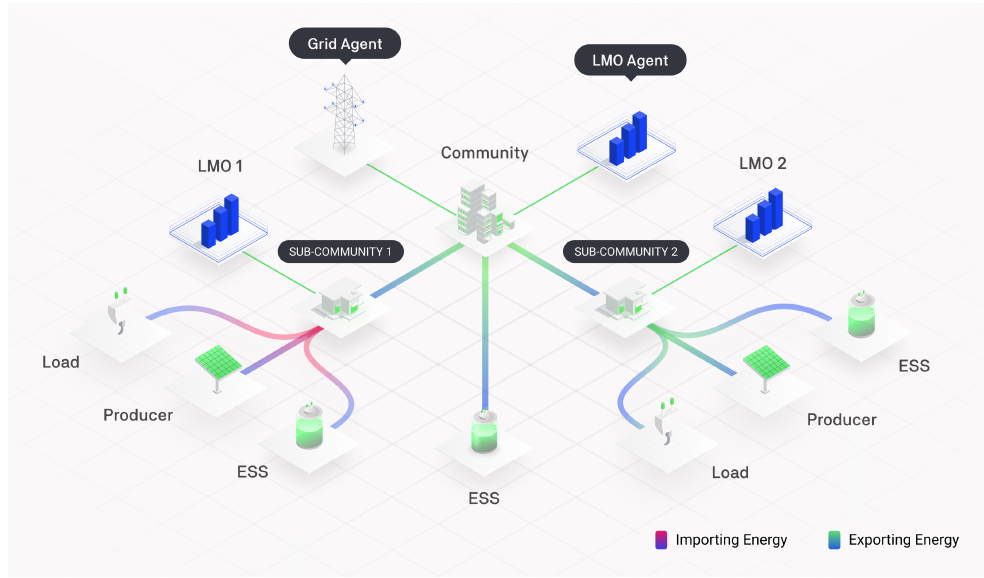
Figure 1. Multi-agent framework and hierarchical structure of LEMs based on the